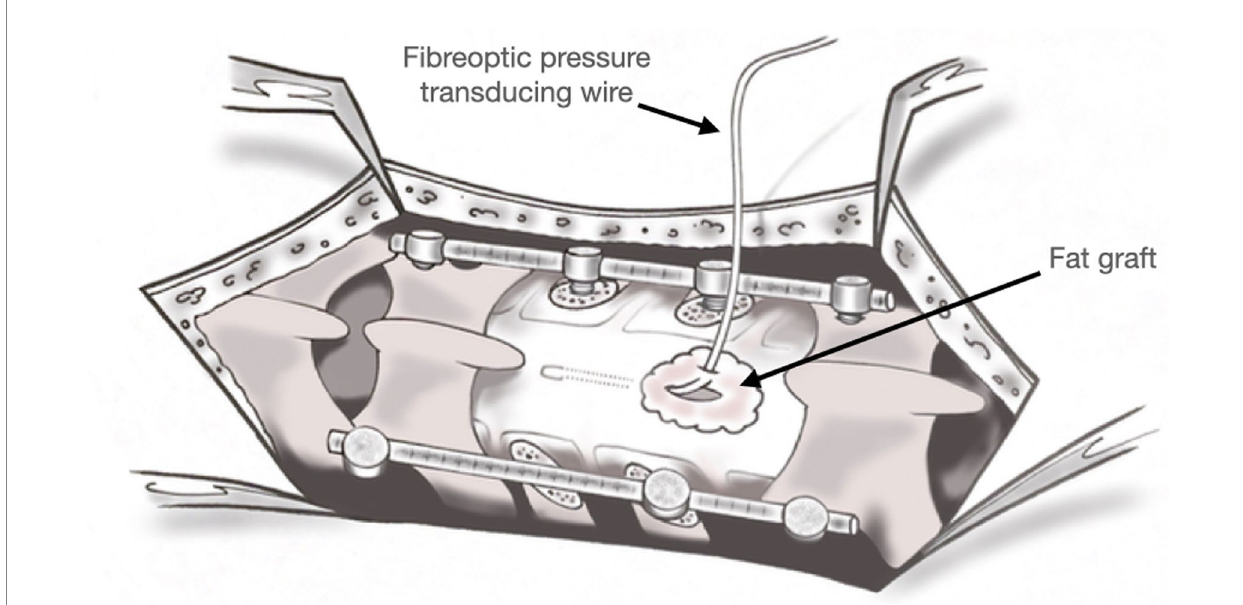
FIGURE 2 Graphical representation of the surgical site. The fiberoptic wire is seen placed through the dura into the subdural space at the site of injury. A fat graft was placed at the site of insertion to prevent pseudomeningocele formation.